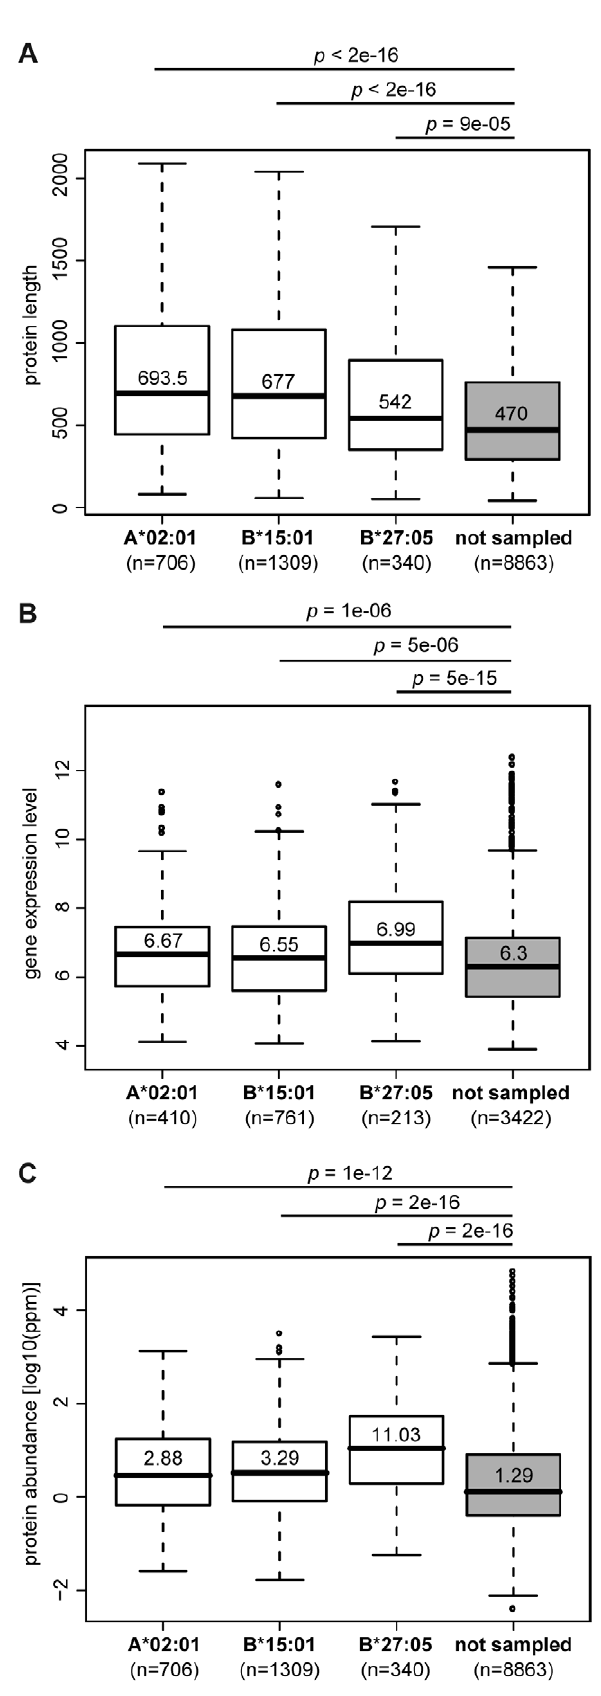
Figure 3. Protein length, gene expression level, and protein abundance impact protein sampling probability. The boxplots compare sampled and non-sampled human proteins in terms of ( A ) protein length, ( B ) gene expression level, and ( C ) protein abundance. The difference in protein counts between plots is due to lack of (gene expression or protein abundance) data for some of the